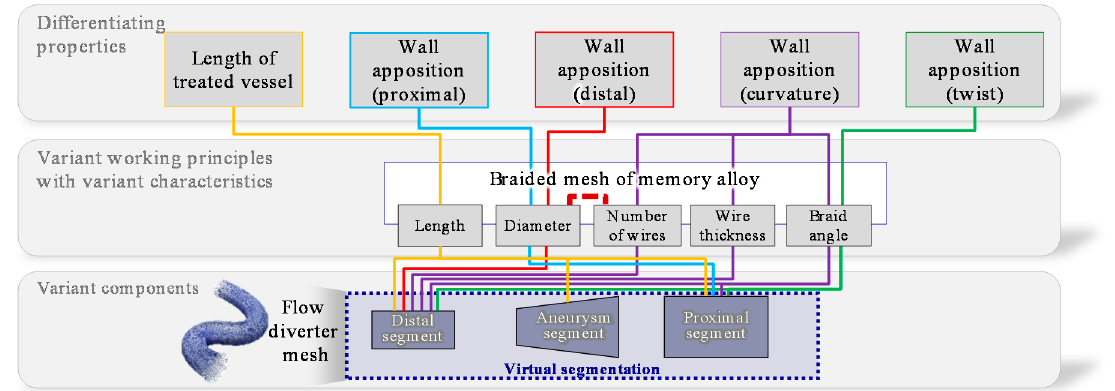
Figure 9. Virtual segmentation of the component Flow diverter mesh component into distal, aneurysm, and proximal segments in line with the ideals of variety-oriented product